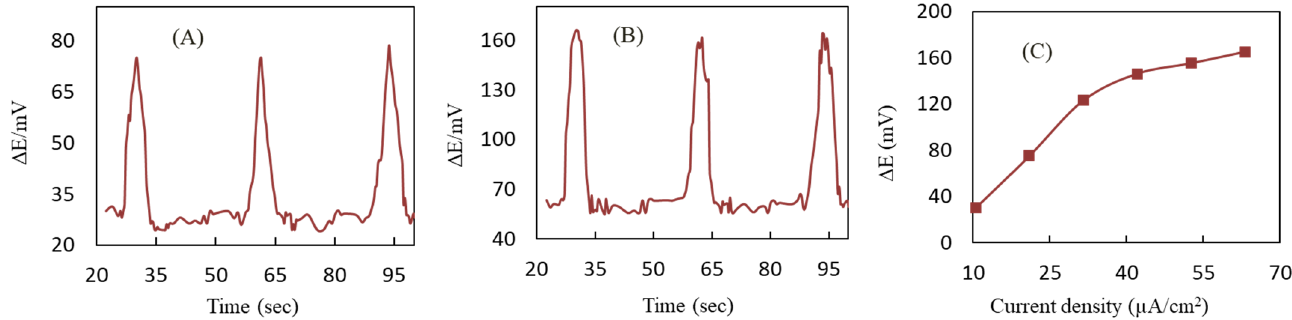
Figure 5. The dependence of SIA-DEP potential peak intensity and shape on the current density value, in triplicate ( A ) 21 µA/cm 2 and ( B ) 63 µA/cm 2 . ( C ) show the average (n = 3) change of peak intensity with di ff erent current density values. Ascorbic acid concentration is 280.0 µM.